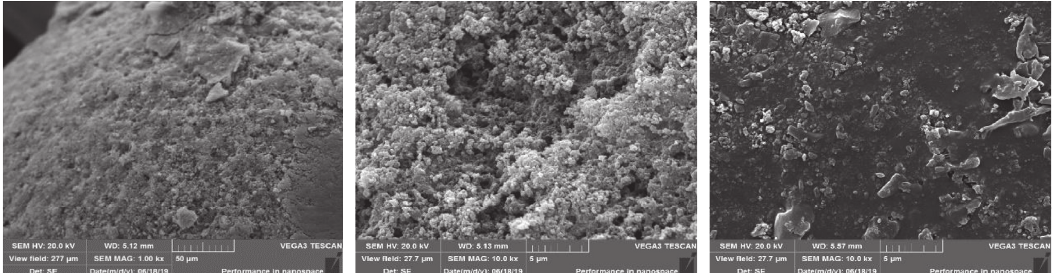
Figure 2: Scanning electron micrographs of the MMIPs and MNIPs: (a) MMIPs; (b) surface of MMIPs; (c) surface of MNIPs.